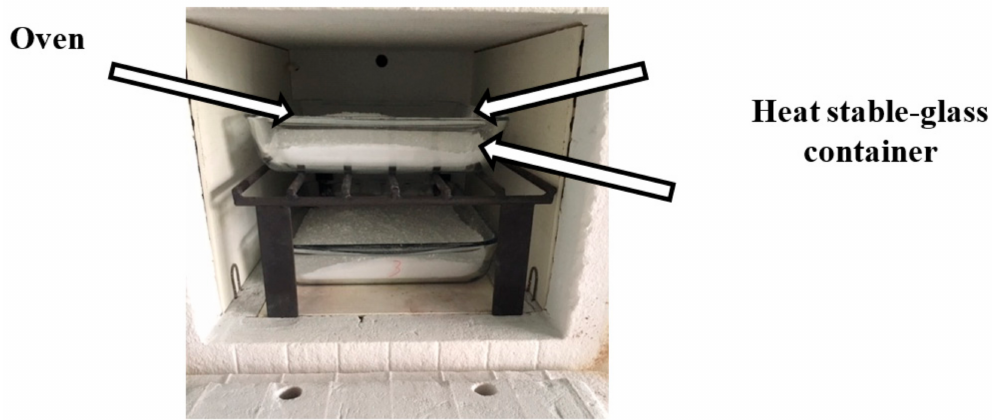
Figure A8. Dehydration of zeolite powder materials in the